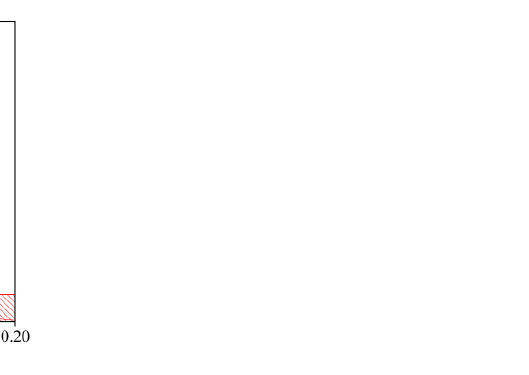
Figure 12. Histogram of the percentage deviation of the model’s data and the experimental values.